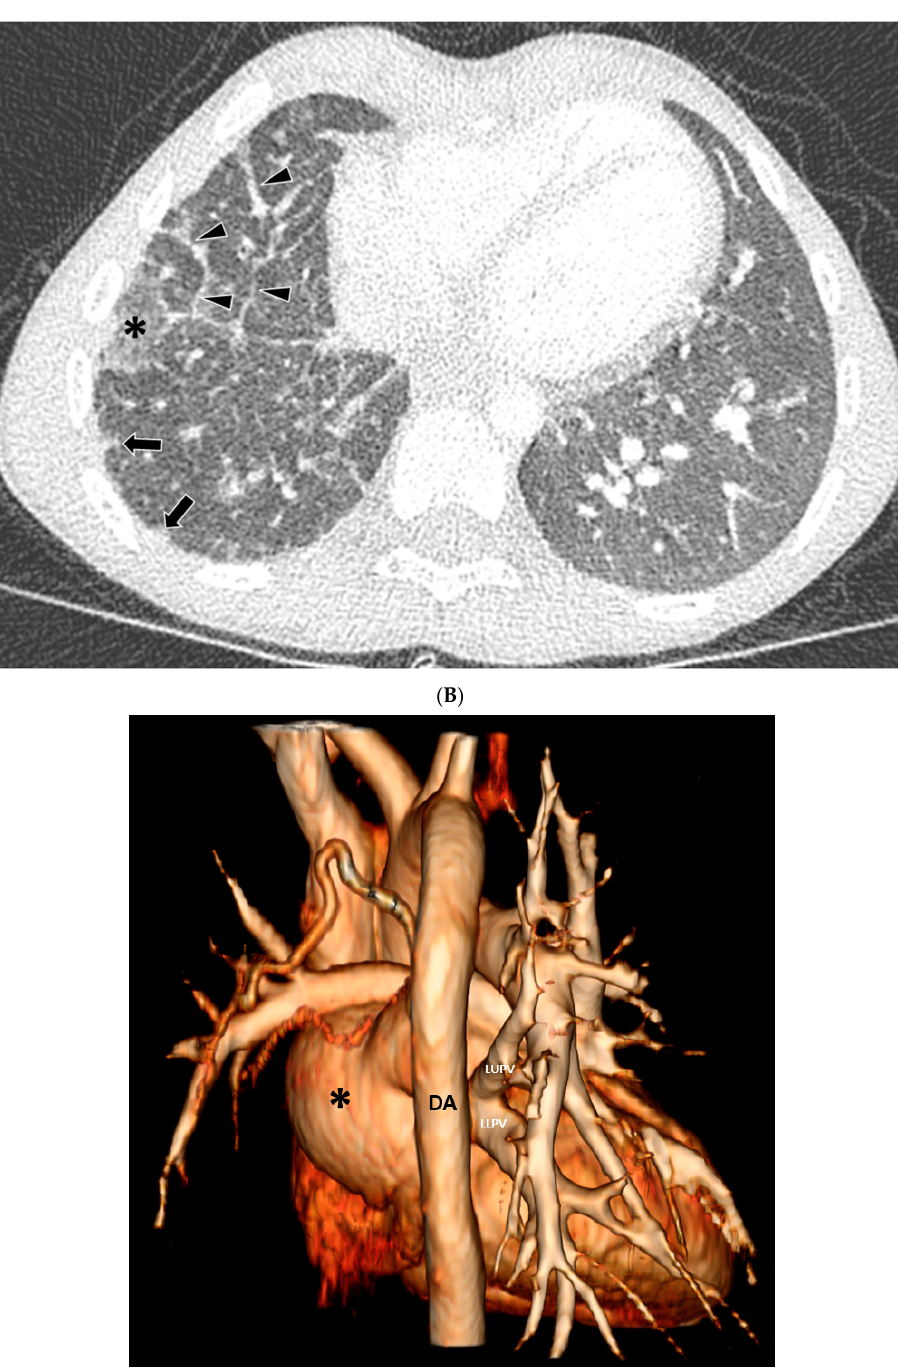
Figure 1. An 8-month-old male with secondary pulmonary vein stenosis due to total anomalous pulmonary venous connection repair who presented with shortness of breath. ( A ) Axial contrast-enhanced thoracic MDCT angiography CT image shows ill-defined, mildly heterogeneously enhancing, non-calcified soft tissue mass (asterisk) in the expected location of the right pulmonary vein. Right pulmonary vein is absent. Pleural thickening (arrow) is seen. Left upper pulmonary vein (LUPV) and left lower pulmonary vein (LLPV) are patent. LA = left atrium. ( B ) Axial lung window CT image demonstrates ground-glass opacity (asterisk) in the right lower lobe, septal thickening (arrowheads), and pleural thickening (arrows). ( C ) 3D volume-rendered vascular reconstruction CT image in the posterior projection view shows absent right pulmonary vein in the expected location (asterisk). Patent left upper pulmonary vein (LUPV) and left lower pulmonary vein (LLPV) are seen. DA = descending